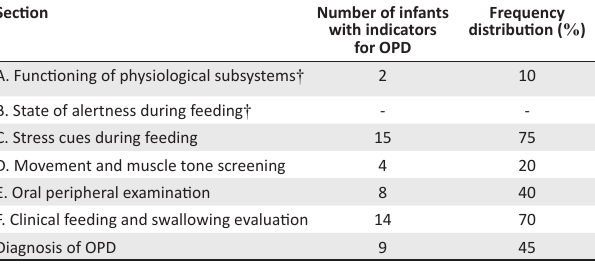
TABLE 3: NFAS results ( n = 20).